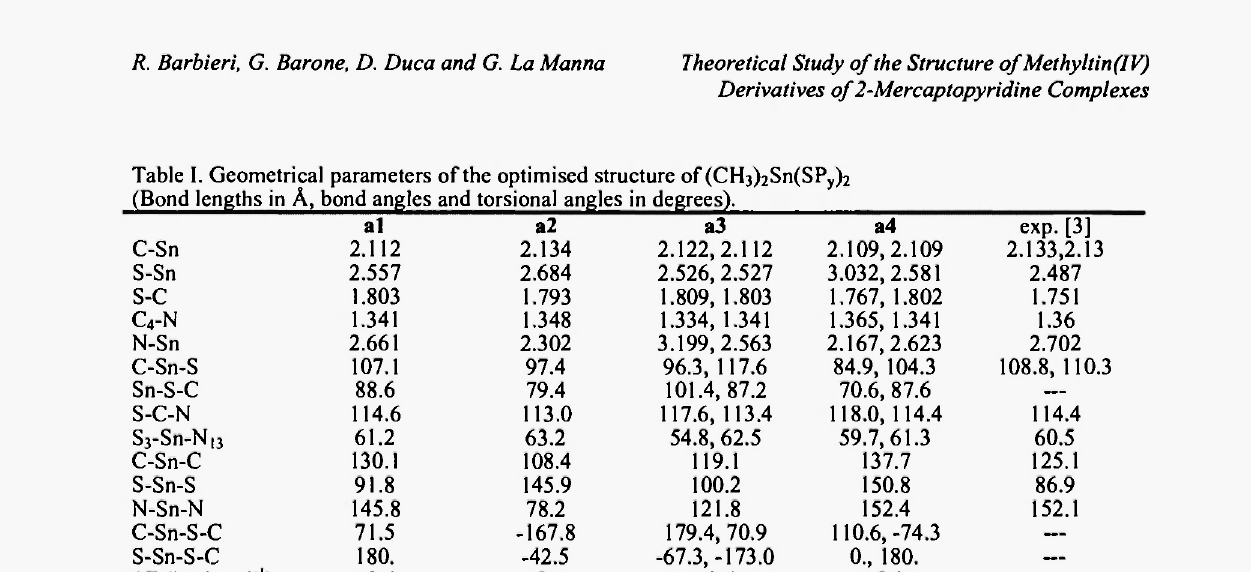
Table I. Geometrical parameters of the optimised structure of (CHj)2Sn(SP y )2 (Bond lengths in A, bond angles and torsional angles in